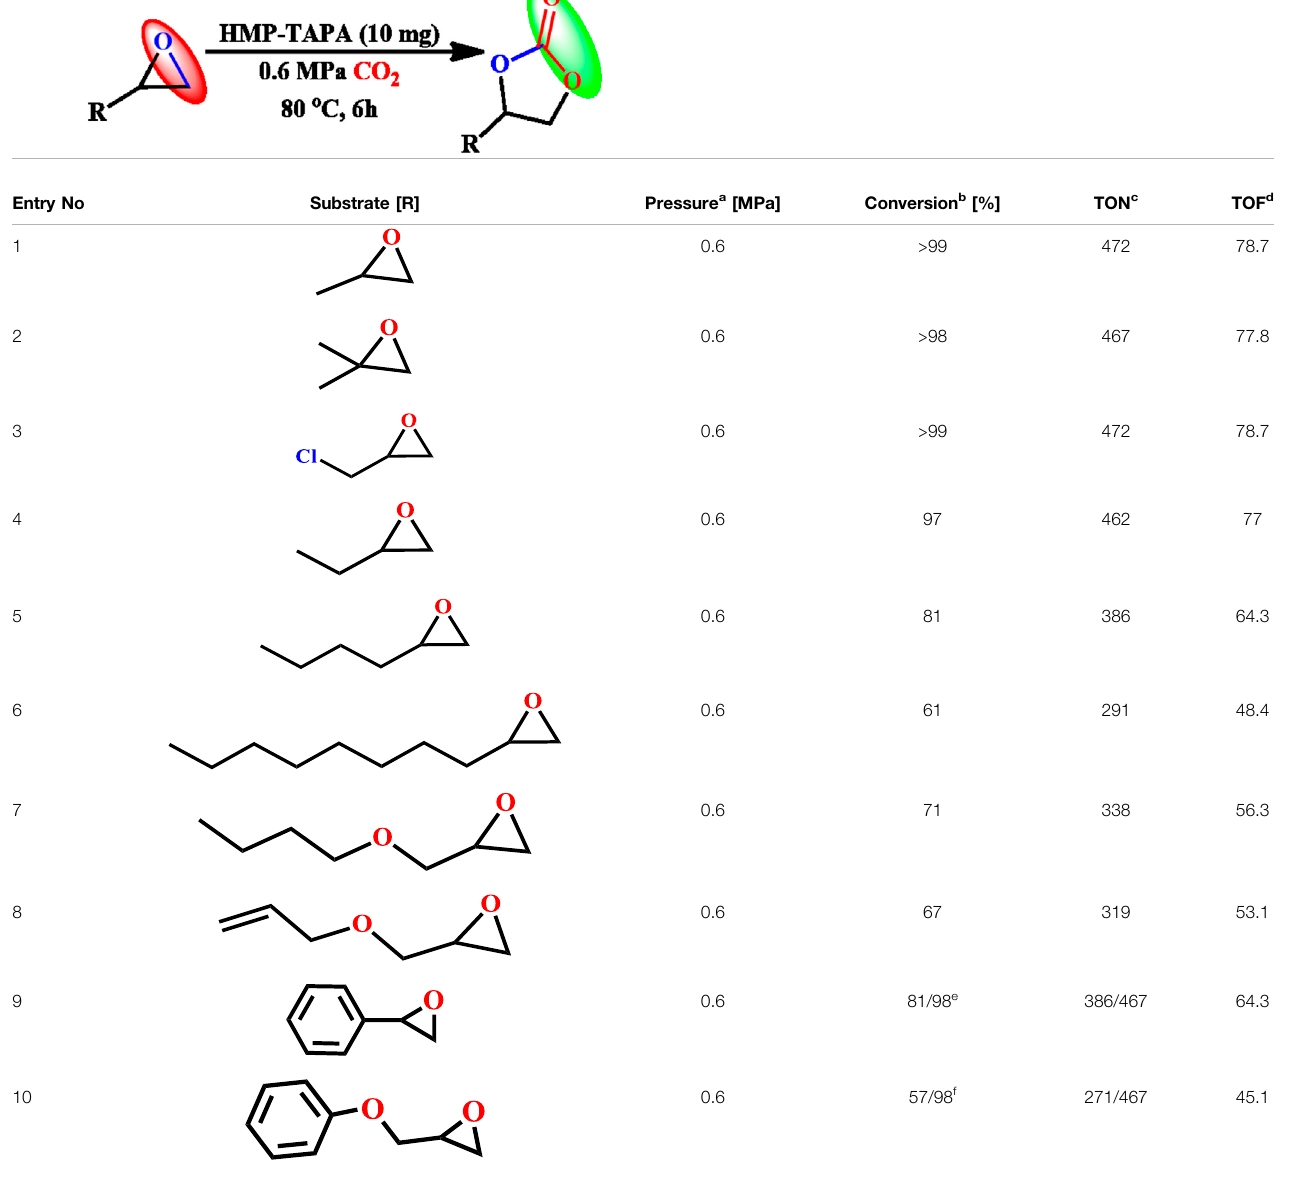
TABLE 2 | Cycloaddition reaction of various substituted epoxides catalyzed by